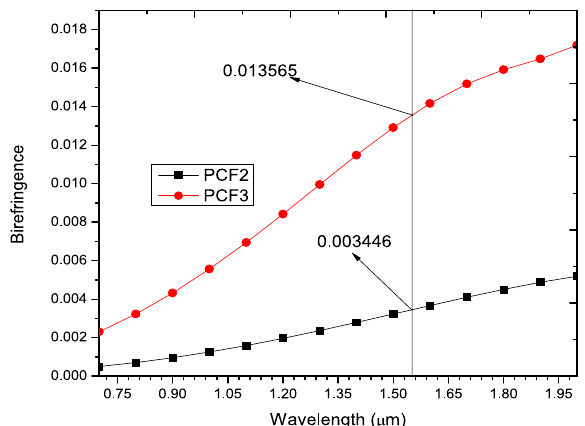
2.3 µm for PCF1 =